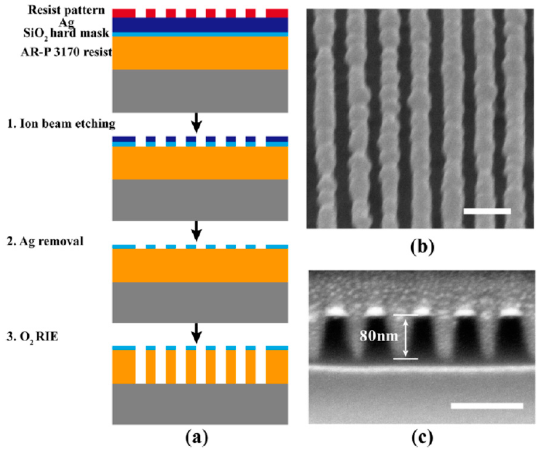
Figure 34. ( a ) Schematic diagram of the resist pattern transfer for plasmonic lithography. SEM pictures of half-pitch 32 nm bottom layer resist pattern ( b ) top view and ( c ) cross sectional view. Scale bar in (b,c), 100 nm. Reproduced from [24], Copyright © 2015, AIP.